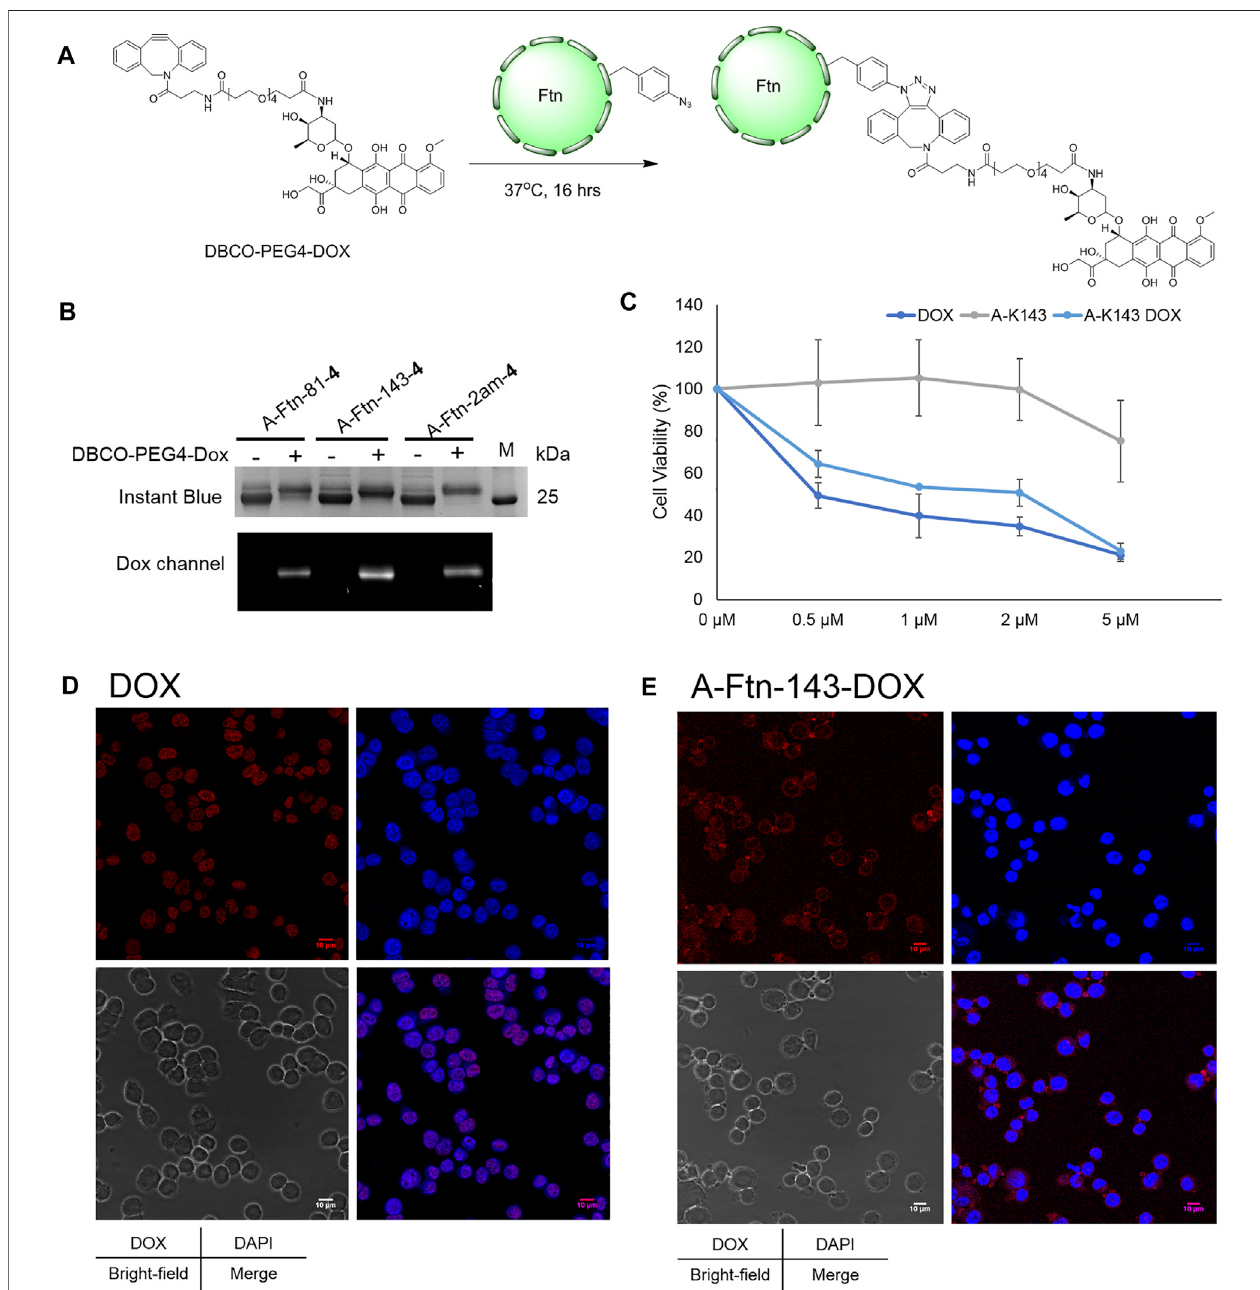
FIGURE 7 | Ftn – Dox conjugates target HER2 overexpressed breast cancer cells. (A) Synthesis scheme of Ftn – Dox conjugates. (B) SPAAC labeling analysis on A-Ftn-81- 4 , A-Ftn-143- 4 , and A-Ftn-2am- 4 by DBCO-PEG4-DOX. Proteins are analyzed by 15% SDS-PAGE with Instant Blue staining (upper panel) and gel fl uorescence image (lower panel) .Mdenotestheprotein molecular weightmarker. (C) MTTassayanalysisaftertreatingwithvarious concentrationsoffreeDox,A-Ftn- 143- 4 (A-K143), and A-Ftn-143-DOX (A-K143 DOX) for 72 h. Confocal microscopy fl uorescence image analysis of BT474 cells incubating with (D) 2 μ M free Dox and (E) 2 μ M A-Ftn-143-DOX treating for 1 h. The cell nuclei are visualized by DAPI staining (blue) and by gel fl uorescence emission image through DOX ( λ ex / λ em (cid:2) 480 nm/590 nm, red).